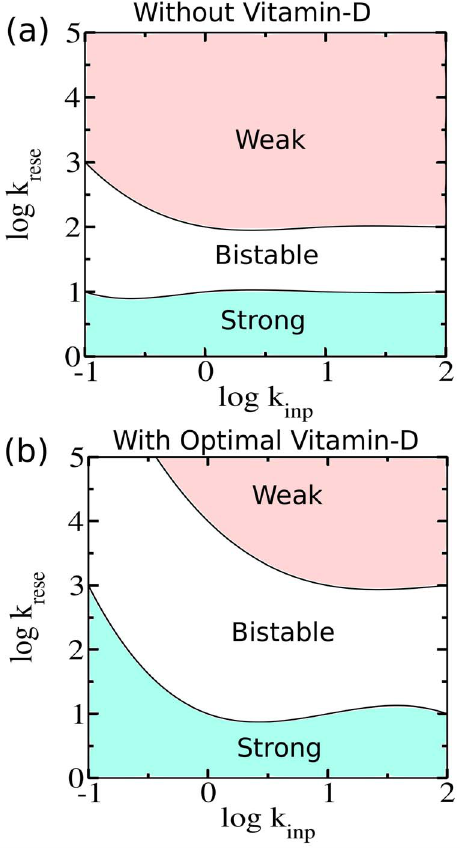
Figure 3. Impact of vitamin-D over the phase diagram of immune regulation. (a) In the absence and presence of vitamin-D, the pair of regulation rates, (i) rate of APC activation mediated by pathogenic stimulation ( k inp ) and (ii) rate of APC activation mediated by effector T-cells ( k rese ) are varied to find out the boundaries between the three specific regulation regions: Weak, moderate, and strong. (a) In absence of vitamin-D the weak regulation intervals occupy a much broader area while areas of moderate (bistable state) and strong regulation intervals are relatively small. (b) In presence of vitamin-D, phase boundaries are shifted: strong regions become broader. Bistable regions become relatively expanded. Weak regions become consider- ably compressed than what happens in absence of vitamin-D. The rate constants considered here are similar to Figure 2.